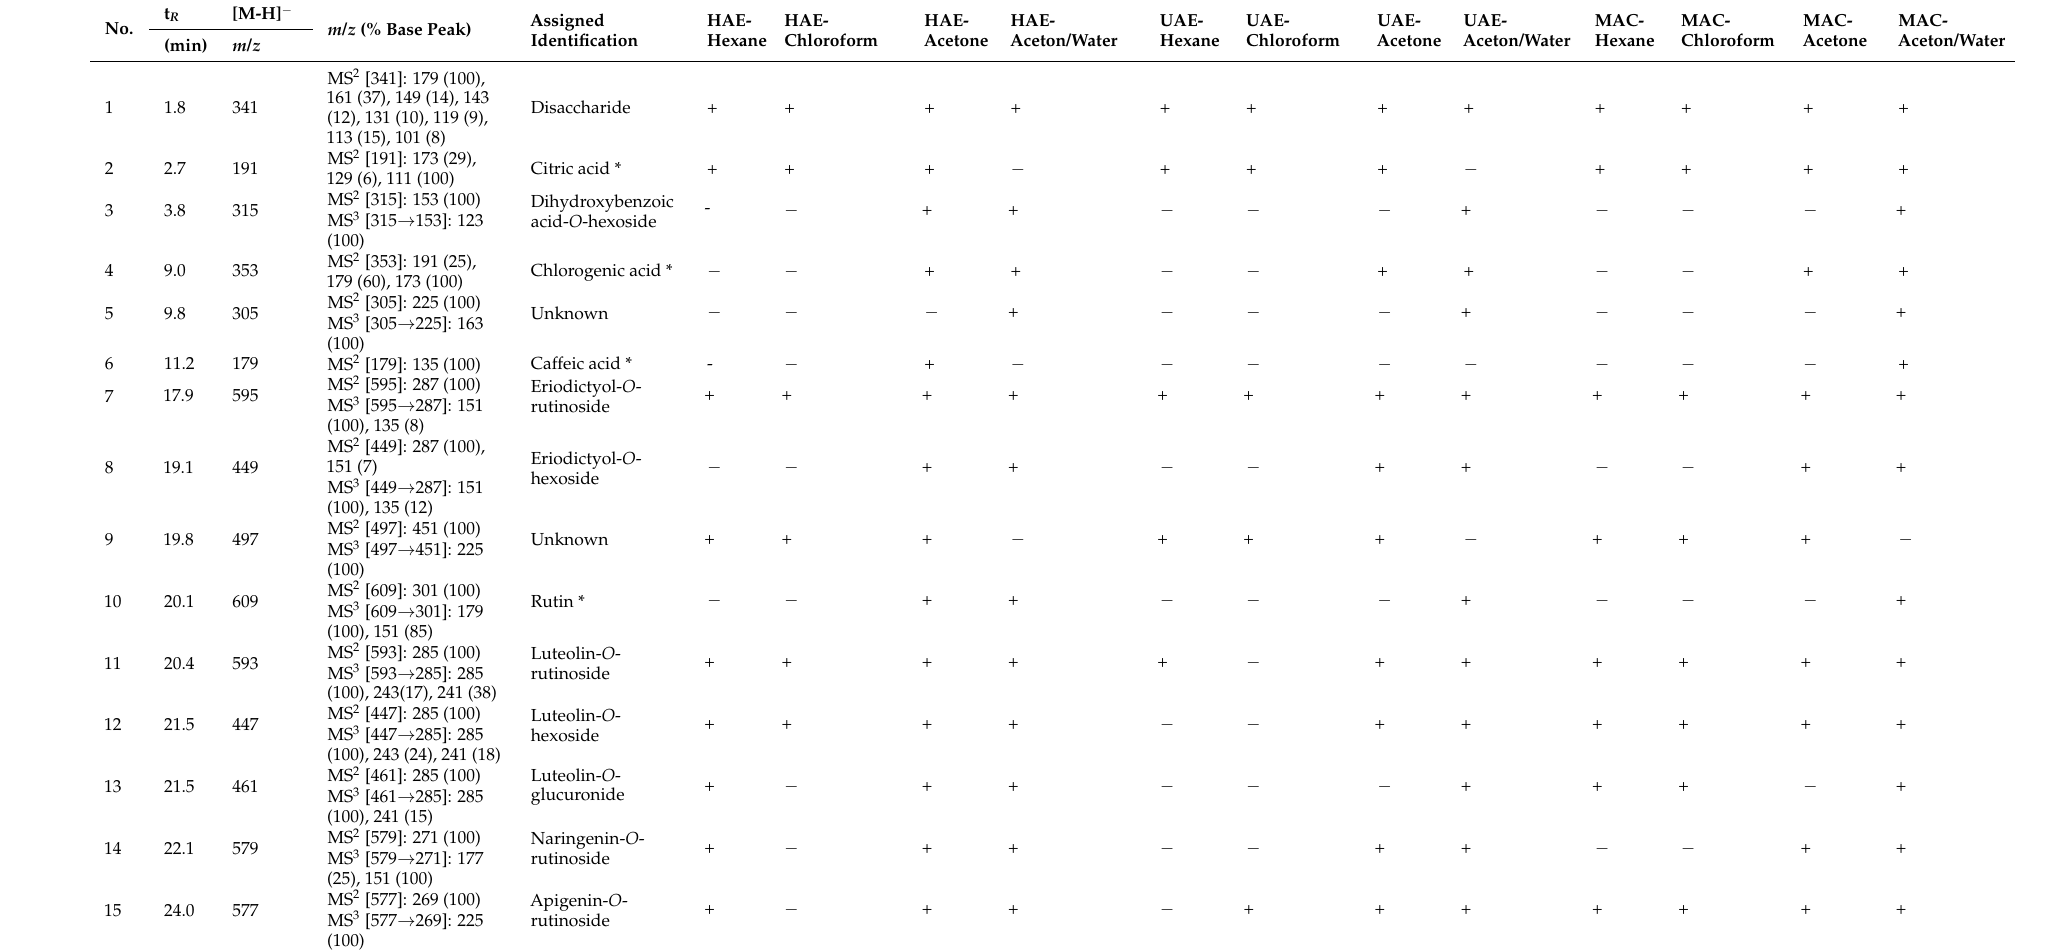
Table 2. Characterization of the compounds found in the analyzed extracts of Mentha spicata